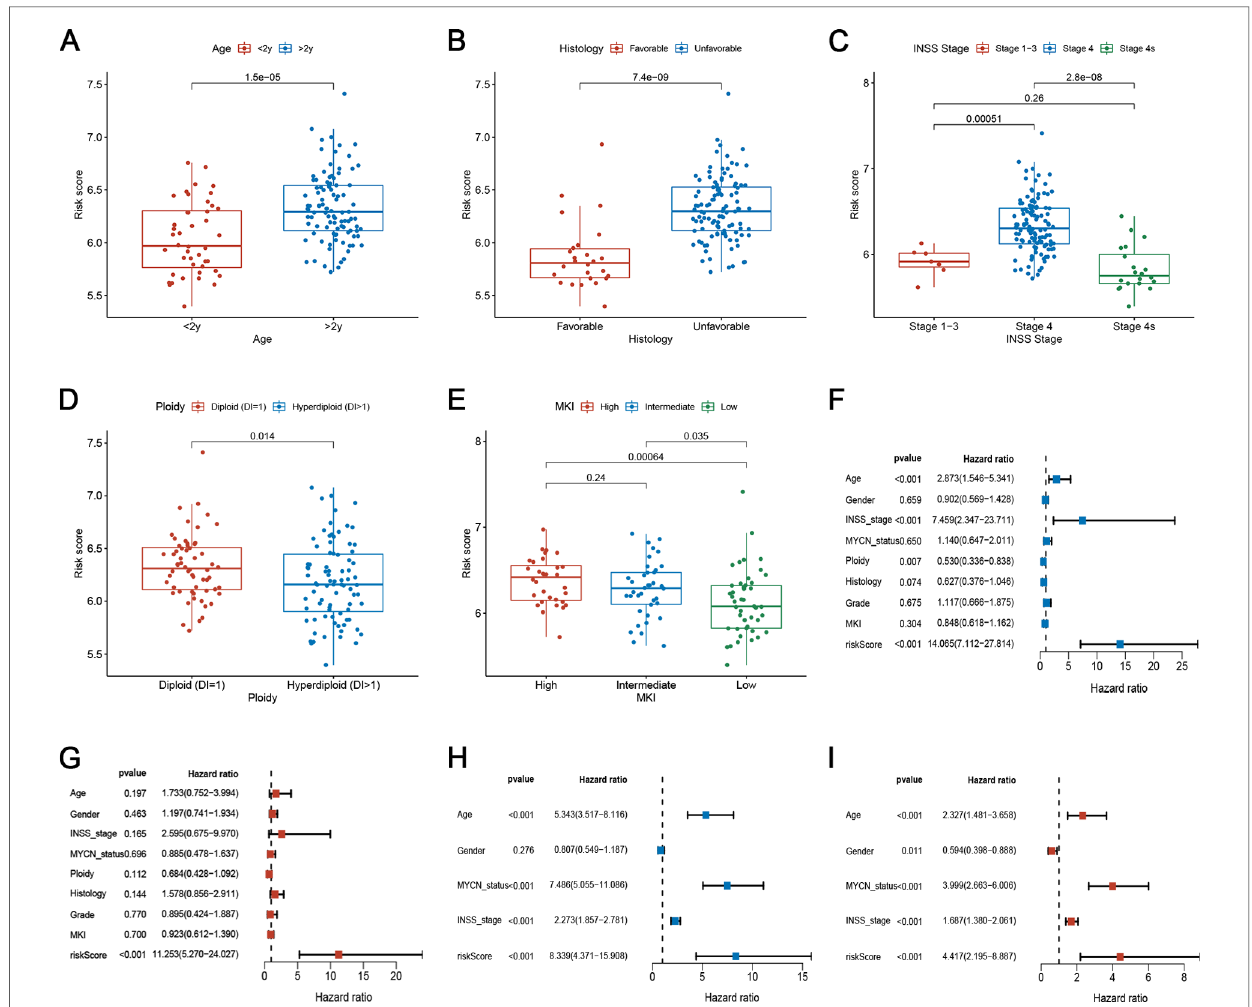
FIGURE 6 Correlation between risk scores and clinical characteristics. ( A – E ) Correlation between risk score and various clinicopathological parameters in the training set. The age, histology, INSS stage, Ploidy, and MKI were used as sample annotations. ( F-G ) Univariate and multivariate Cox analyses of risk scores and clinical traits in the training set. ( H – I ) Univariate and multivariate Cox analyses of risk scores and clinical features in the testing